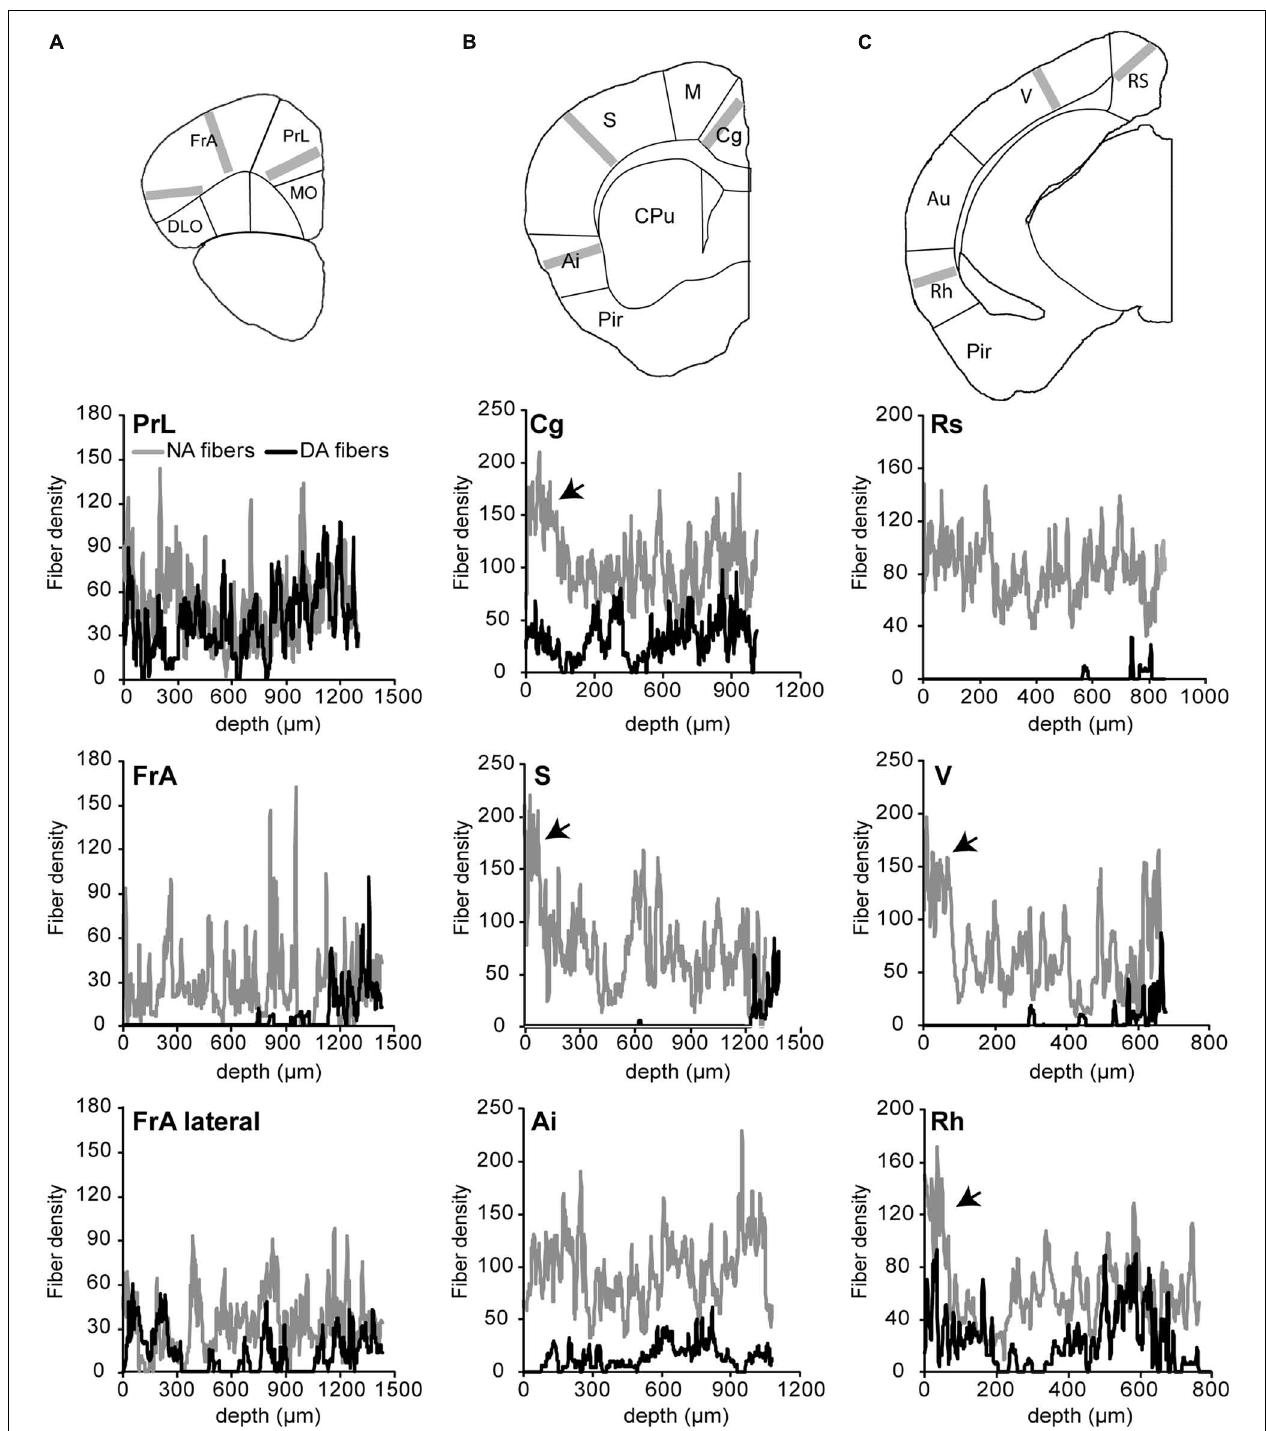
FIGURE 2 | Density of noradrenergic and dopaminergic fibers in various areas of the cortex. The density of fibers was obtained from the drawings shown in Figure 1 on lanes of 200 pixels (260 μ m) width orthogonal to the pial surface, as depicted in images of the upper panel (gray bars).The fiber density, measured in three regions of anterior (A) , intermediate (B) , and posterieor (C) coronal brain sections, corresponds to the averaged pixel value